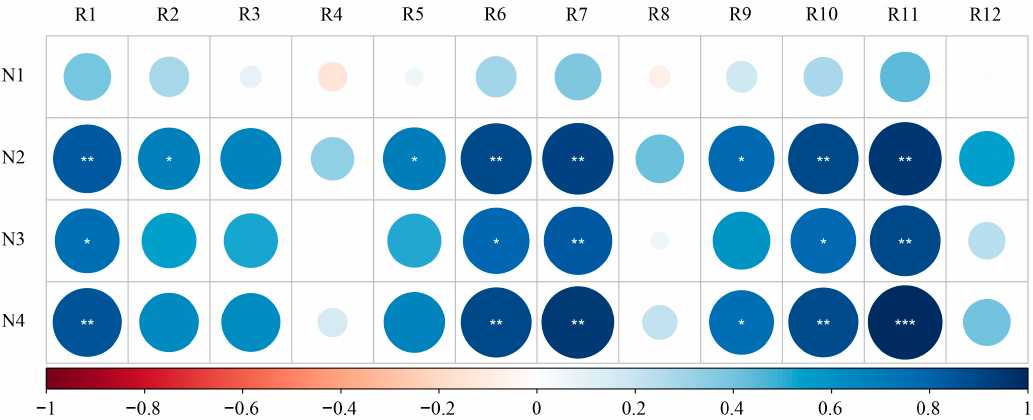
Figure A2. Effect of integrated cultivation practices on nitrogen accumulation in each organ of two wheat cultivars Yangmai 16 ( A , B ) and Yangmai 20 ( C , D ) in 2020–2021. LP, NR, DN, and OF indicate local customs, nitrogen reduction, planting density reduction and nitrogen reduction, and organic fertilizer, respectively. The vertical bar represents the ±standard error of the mean. Different lower- case letters indicate the same organ; the difference between different treatments was significant at the 0.05 level.